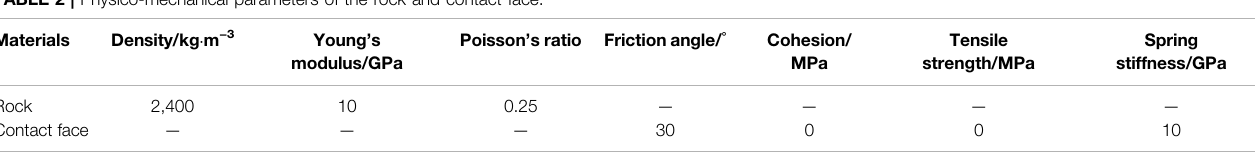
velocity in the Z -direction shows that, before each collision, the velocity vector of the rock block points downslope; when a collision occurs, the velocity of the rock block suddenly changes to upslope, reducing the kinetic energy; after the collision, the rock block moves freely in the air, the velocity